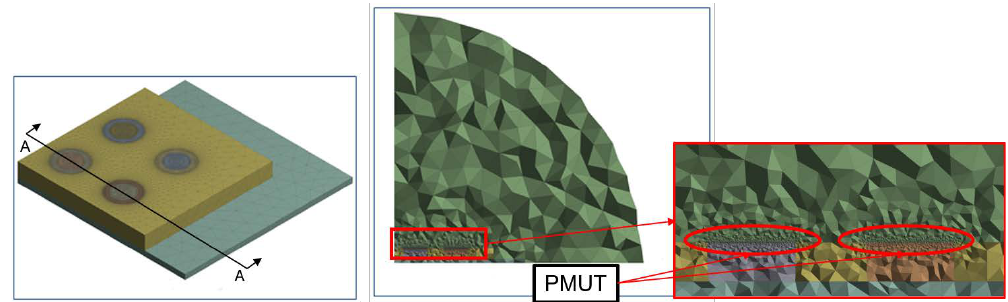
Figure 4. Geometry for the electro-mechanical-acoustic model: a quarter of 4 × 4 array of PMUTs ( left ), cross section of the transducers with the cavity ( center ), solid and acoustic domain ( right ).